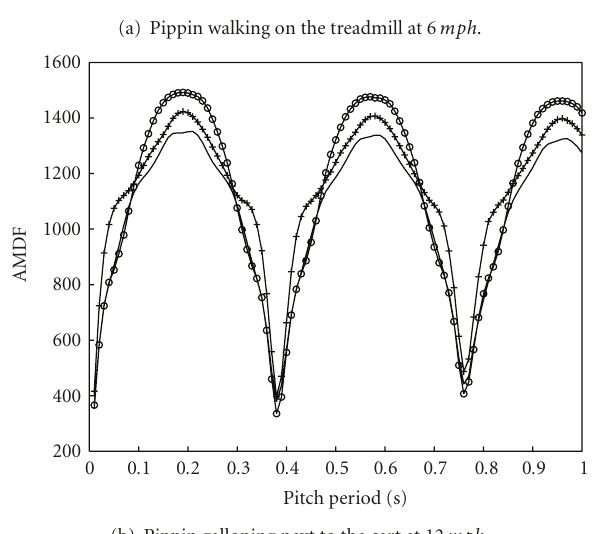
Figure 13: Stride frequency and velocity of Pippin. Circles indicate a walking gait, and asterisks indicate a galloping gait. Lines indicate best-fit linear regression for each gait.